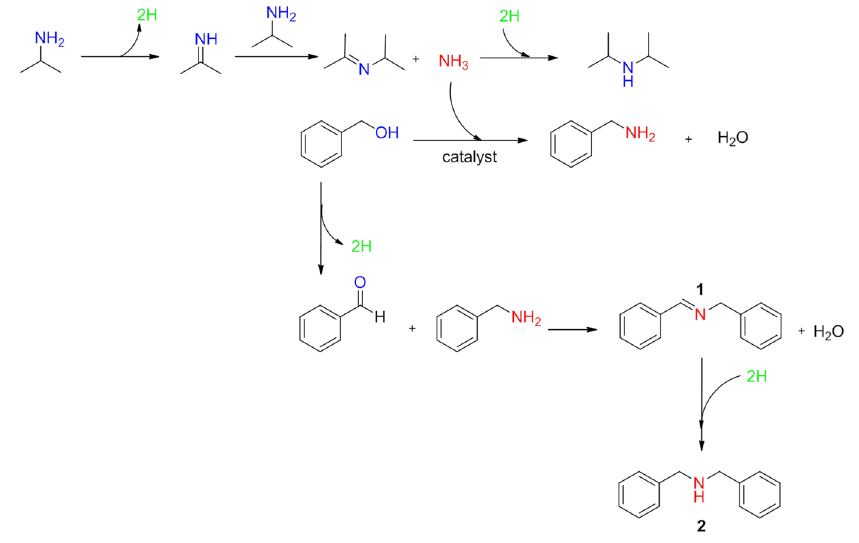
Scheme 2. Possible parallel reactions during reductive amination of benzyl alcohol with isopropylamine.